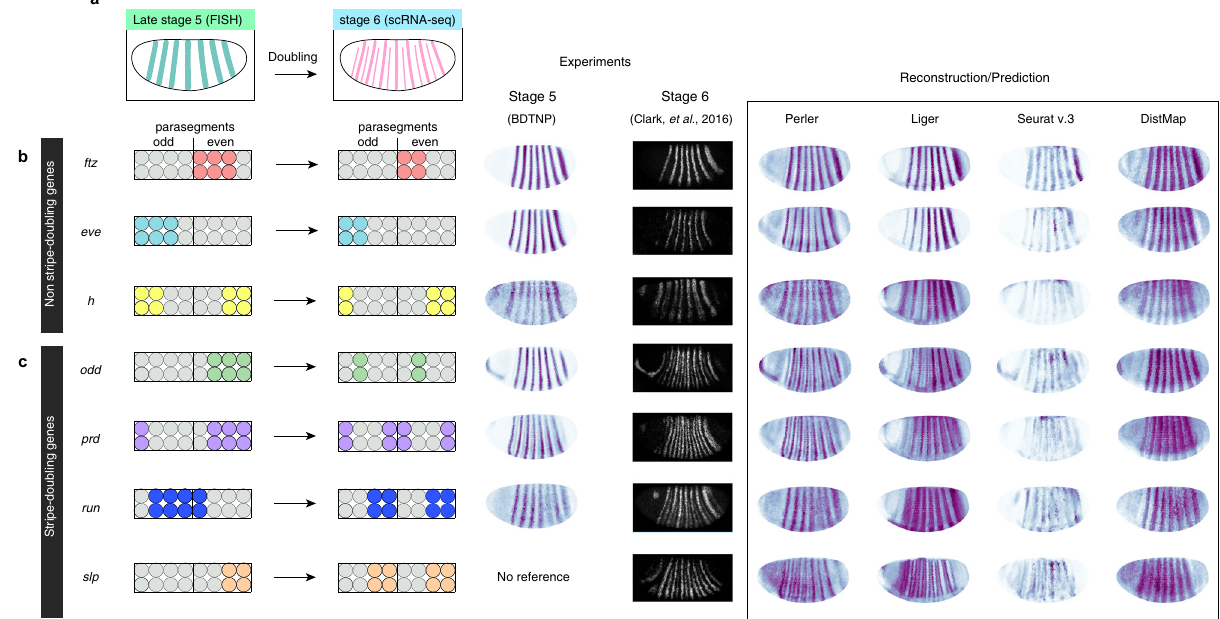
Fig. 5 Generalization to spatial reference maps by Perler. a Stripe-doubling of pair-rule genes from Drosophila developmental stage 5 (FISH experiment) to stage 6 (scRNA-seq experiment). b , c Left panels: images of expression changes in b non-stripe-doubling genes and c stripe-doubling genes. Middle panels: experimental ISH data of stage 5 (BDTNP) and stage 6 (Clark et al. 29 ). Right panels: gene expression reconstructed/predicted by Perler, Liger, Seurat (v.3), and DistMap. Note that slp expression was predicted. Experimental ISH data were reprinted from Clark et al. 29 under a Creative Commons License (Attribution 4.0 International